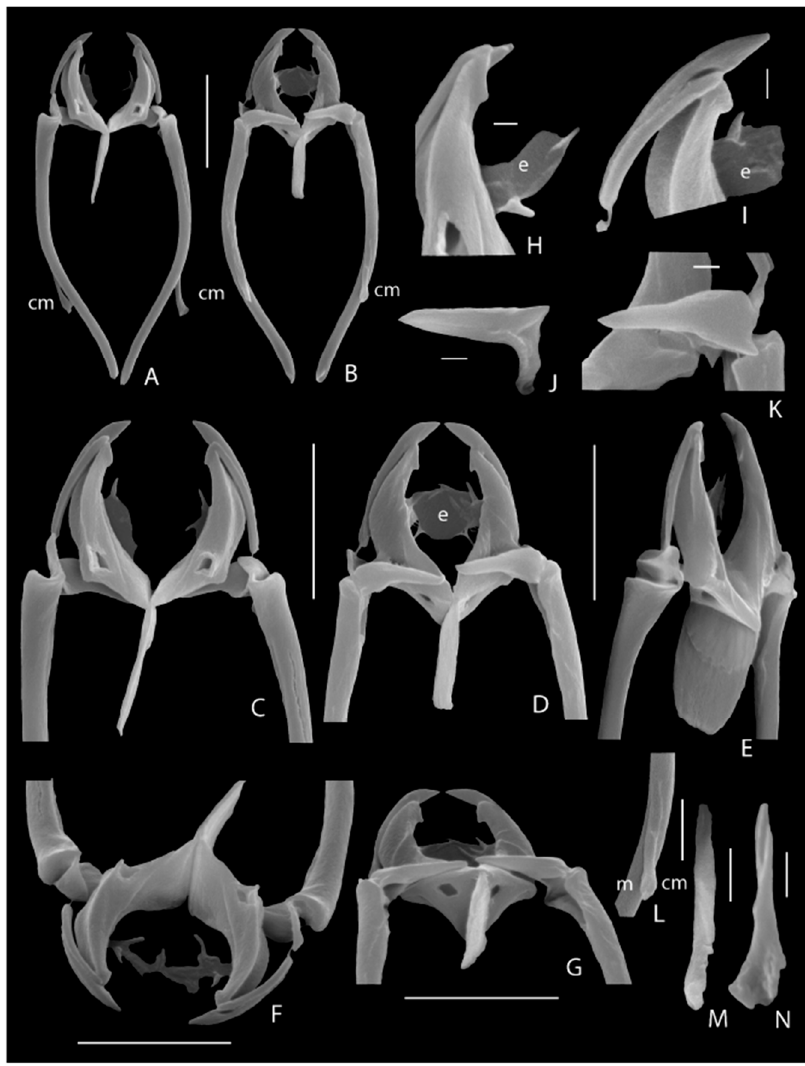
Figure 5. Encentrum rousseleti (Lie-Pettersen, 1905), SEM photographs of trophi. ( A ) Complete set, dorsal. ( B ) Complete set, ventral. ( C ) Detail, dorsal. ( D ) Detail, ventral. ( E ) Detail dorso-lateral. ( F ) Detail, dorso-frontal. ( G ) Detail, ventro-caudal. ( H ) Detail left ramus tip and epipharynx, dorsal. ( I ) As Figure H, dorso-lateral. ( J ) Right supramanubrium, caudal. ( K ) Left supramanubrium, ventral. ( L , M ) Calcar manubrii, ventral. ( N ) Calcar manubrii, dorsal. ca: caudal antenna; cm: calcar manubrii; e: epipharynx; m: manubrium. Scale bars: ( A − G ): 10 µm; ( H − K ): 1 µm, ( L ): 5 µm; ( M , N ): 2 µm. Material examined: New Jersey (site 125; marsh; S = 34‰) and Massachusetts (site 144; marsh; S = 10‰); additional material: several specimens from a brackish puddle at Ambleteuse, the Channel,